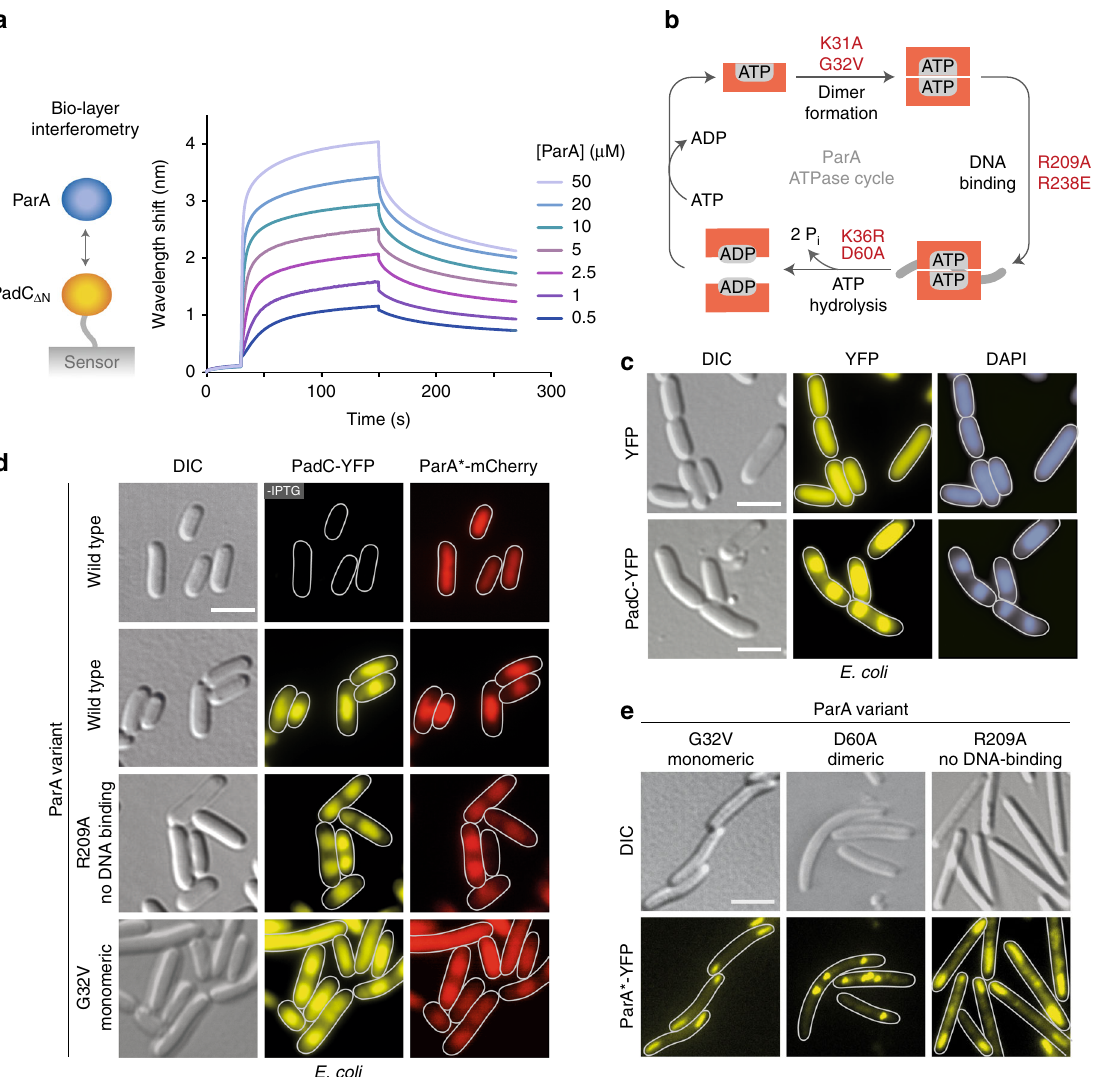
Fig. 5 PadC interacts with ParA. a Bio-layer interferometric analysis of the interaction between PadC and ParA. Sensors loaded with biotinylated PadC Δ 1-281 (PadC Δ N ) were probed with the indicated concentrations of ParA. The extent of non-speci fi c binding of ParA to the sensor surface was negligible (Supplementary Fig. 5d). b Putative ATPase cycle of ParA. Monomeric ParA binds ATP and dimerizes. The dimeric complex is able to interact non- speci fi cally with chromosomal DNA. Spontaneous or ParB-stimulated ATP hydrolysis leads to dissociation of the ParA dimer and nucleotide exchange, thereby restarting the cycle. Mutations affecting speci fi c steps of the ParA ATPase cycle are indicated in red. c DNA-binding activity of PadC. Cells of E. coli BL21(DE3) were transformed with plasmids pLL137(P T7 - eyfp ) or pLL101 (P T7 - padC-eyfp ) and induced for 4 h with 0.5 mM IPTG before imaging. DNA was stained with DAPI (bar: 3 µ m). The PCC for the DAPI and PadC-YFP signals is 0.94 ± 0.04 ( n = 47 cells). d Colocalization of PadC with different ParA variants in E. coli . Cells of E. coli BL21(DE3) bearing pLL101 (P T7 - padC-eyfp ) were transformed with pLL100 (P tet - parA-mCherry ), pLL124 (P tet - parA R209A - mCherry ), or pLL172 (P tet - parA G32V -mCherry ) and induced with 0.5 mM IPTG (for 2 h) and/or 0.2 µ g/ml aTet (for 1 h) before imaging (bar: 3 µ m). The PCCs for the PadC-YFP and ParA * -mCherry signals are 0.93 ± 0.05 (WT, n = 52 cells), 0.92 ± 0.11 (R209A, n = 52 cells), 0.90 ± 0.10 (G32V, n = 51 cells).